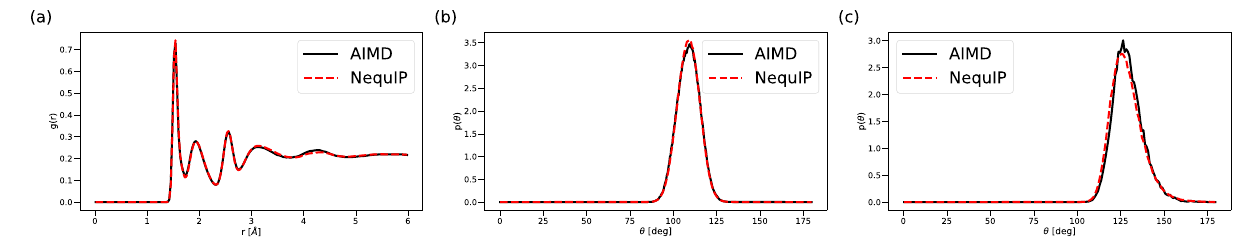
Fig. 3 Structure of Li 4 P 2 O 7 . a Radial Distribution Function, ( b ) Angular Distribution Function, tetrahedral bond angle, ( c ) Angular Distribution Function, bridging oxygen. All are de fi ned as probability density functions; NequIP results are averaged over 10 runs with different initial velocities.